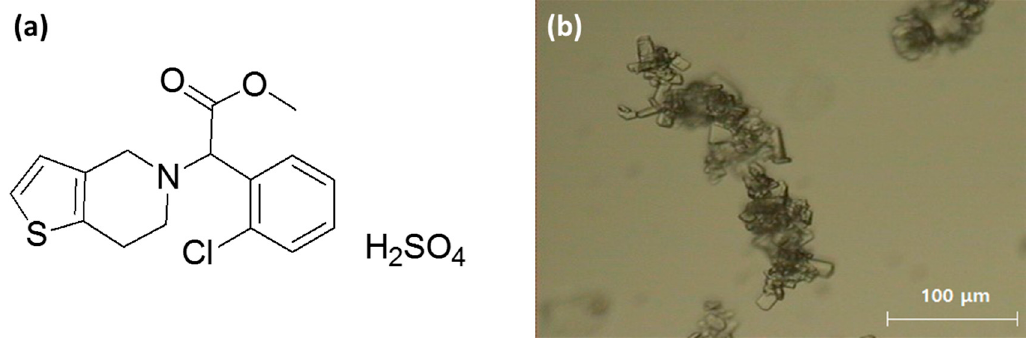
Figure 1. ( a ) Molecular structure of clopidogrel bisulfate (CLP) and ( b ) video-microscopic image of CLP Form-I.